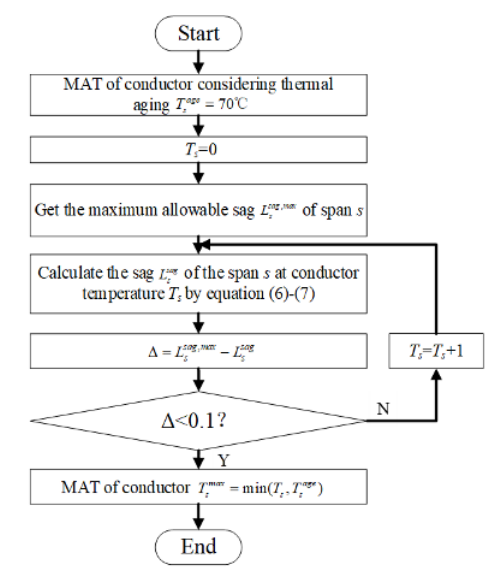
Fig. 1. Flowchart of determination of MAT. The MAT T max